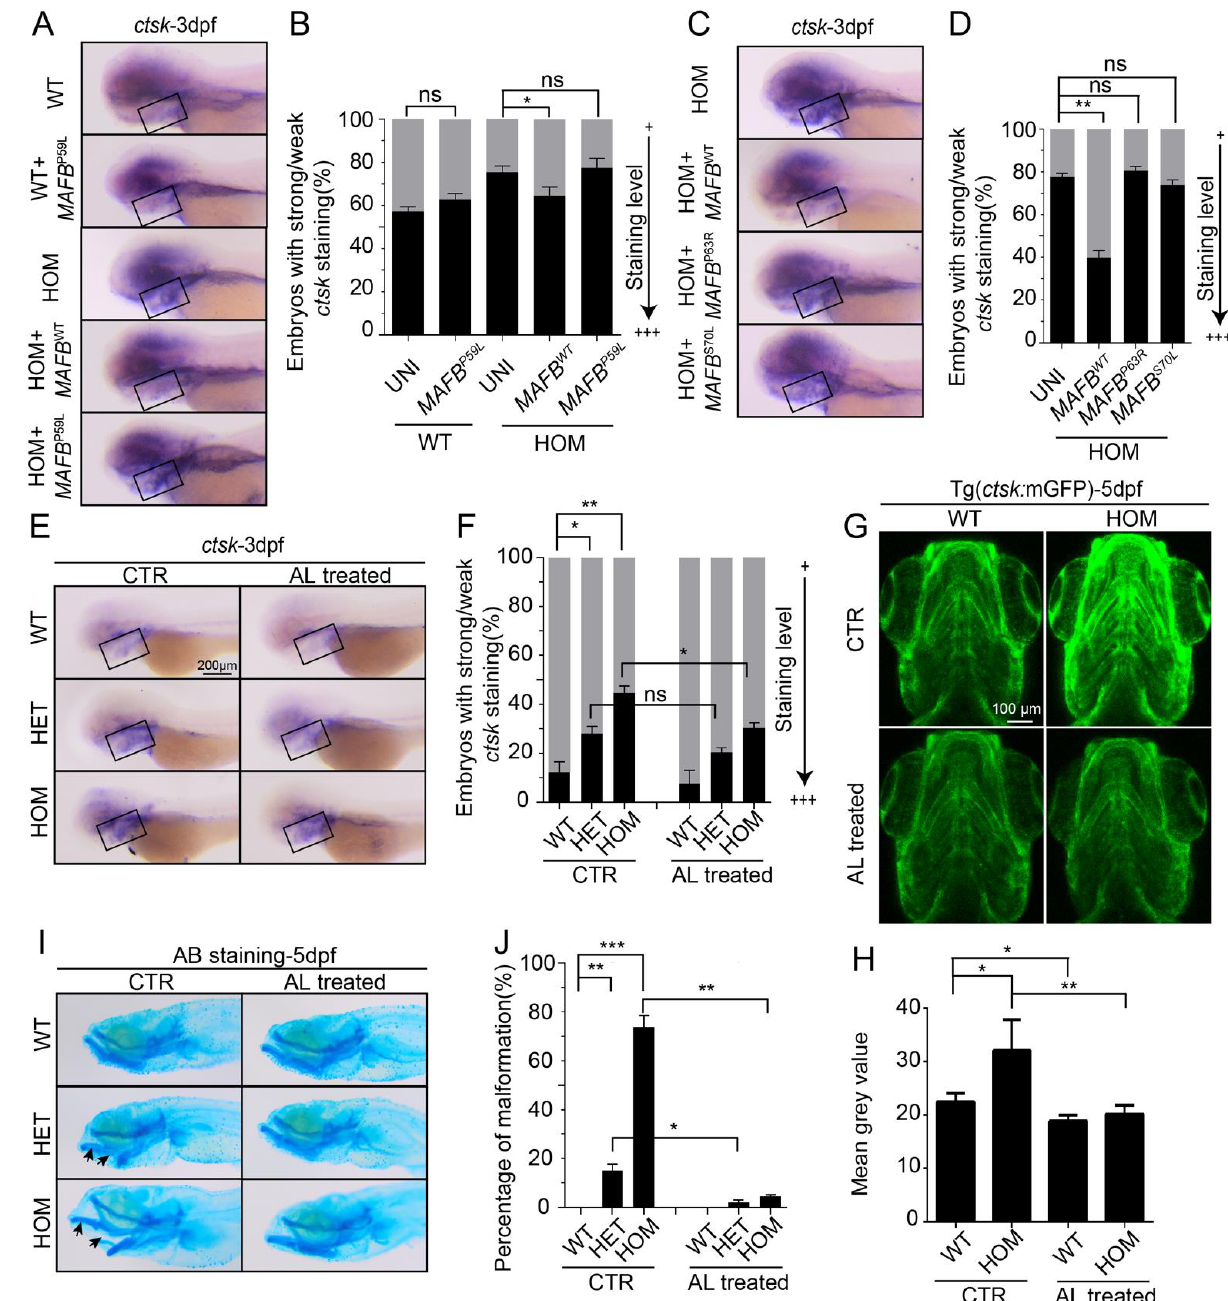
Figure 6. Rescue of mafbb −/− embryos by WT and MCTO mutant MAFB and alendronate. ( A ) WISH of ctsk expression at 3 dpf in WT uninjected embryos, WT embryos injected with human P59L mutant MAFB mRNA, HOM uninjected embryos, and HOM embryos injected with human WT or P59L mutant MAFB mRNA. ( B ) Quantification of the ctsk expression in A. ( C ) WISH of ctsk expression at 3 dpf in HOM uninjected embryos, HOM embryos injected with human WT, P63R or S70L MAFB mRNA. ( D ) Quantification of the ctsk expression in C. ( E ) WISH of ctsk expression at 3 dpf in untreated and alendronate (AL)-treated embryos. ( F ) Quantification of the ctsk expression at 3 dpf in E. ( G ) Fluorescent images of Tg( ctsk :mGFP) at 5 dpf in WT and HOM embryos (the ventral view of head). ( H ) Mean grey value of fluorescence intensity of the images in G (n = 5 zebrafish per group). ( I ) AB staining of cartilages at 5 dpf in untreated and AL-treated embryos. Arrows indicate the lower jaw protrudes. ( J ) Quantification of AB staining in I. N = 50–100 embryos per group for A–F and I–J. WT, wild type; HET, mafbb d 11 /+ ; HOM, mafbb d 11 /d 11 ; AL, alendronate. Results in B, D, F, J and H are expressed as mean ± SEM, (* p < 0.05, ** p < 0.01, *** p < 0.001, t test, ns, not significant).